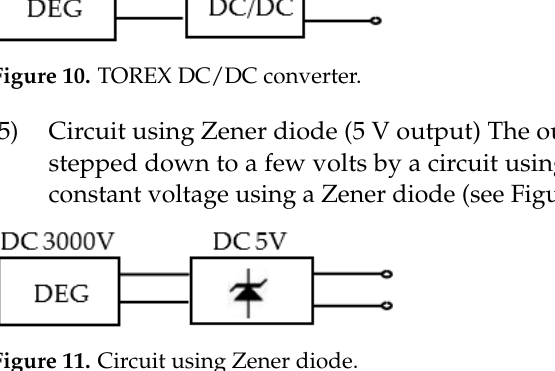
Figure 11. Circuit using Zener diode.